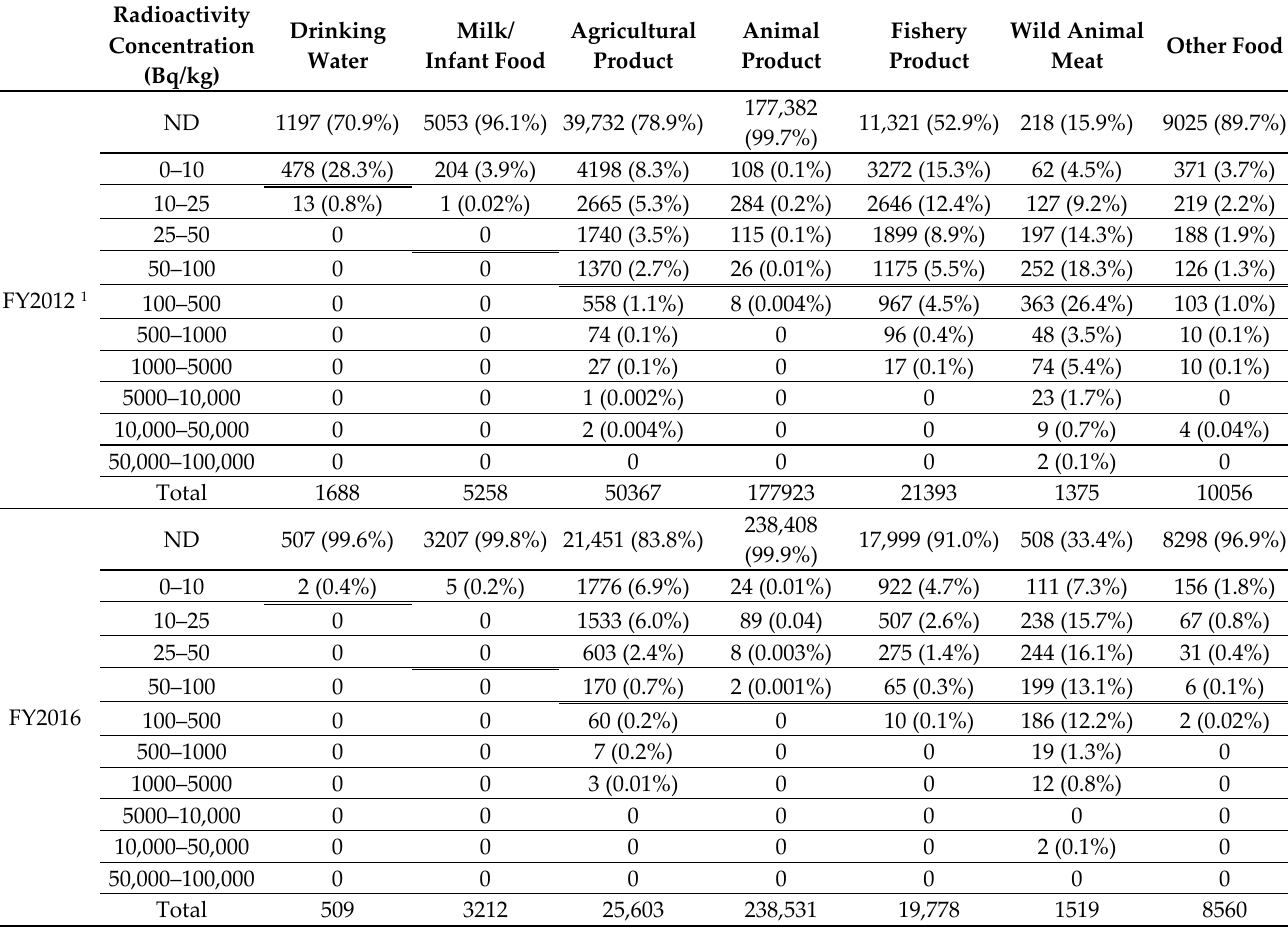
Table 3. Number and percentage of monitoring results throughout Japan according to the radioactivity concentration in each rough food category. The percentage is given in parentheses.